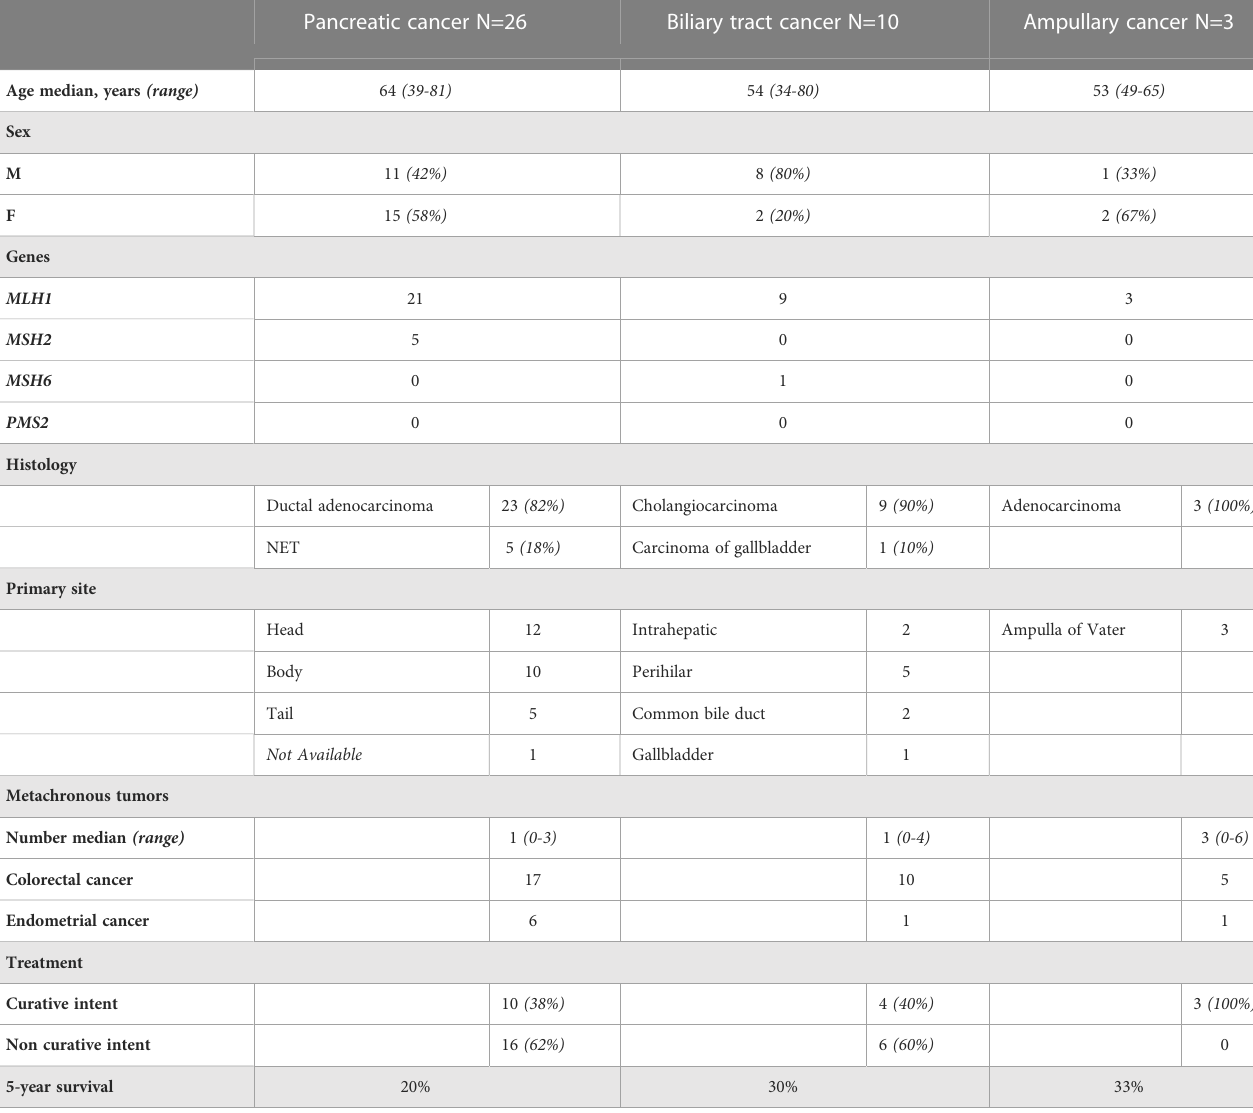
TABLE 2 Overview of clinical characteristics and treatment in LS patients with pancreatic, biliary tract and ampullary cancer. Pancreatic cancer